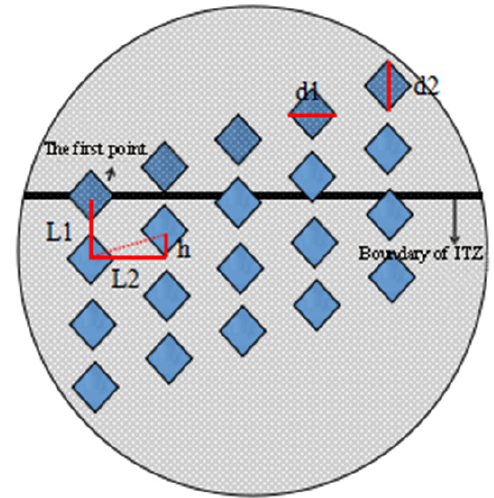
Figure 4. Schematic diagram of micro-hardness tester: d1, d2—diagonal length of indentation at microhardness measuring point, L1–longitudinal spacing of indentation center points, L2–transverse horizontal spacing of indentation center point.